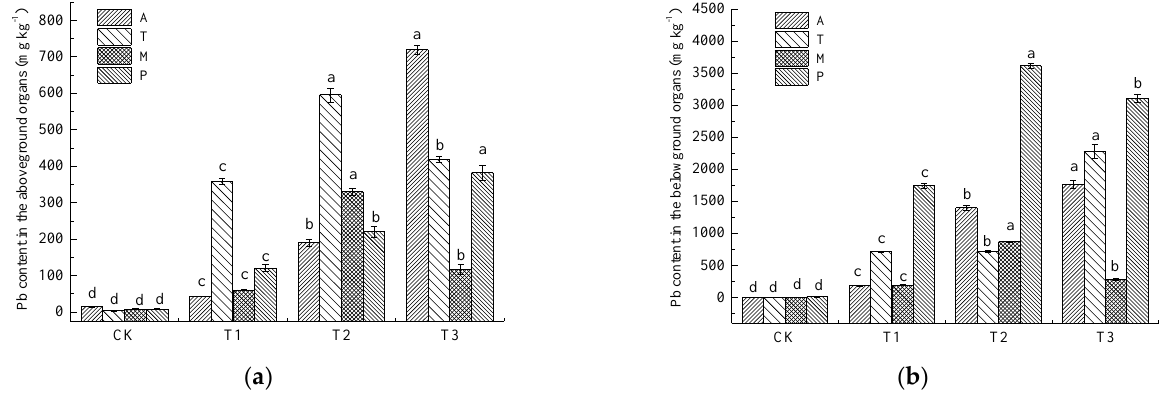
Figure 3. Total biomass of native plant species under different treatments in Pb-polluted soil. Means ± SE with different letters indicate significant differences according to LSD testing ( p < 0.05).